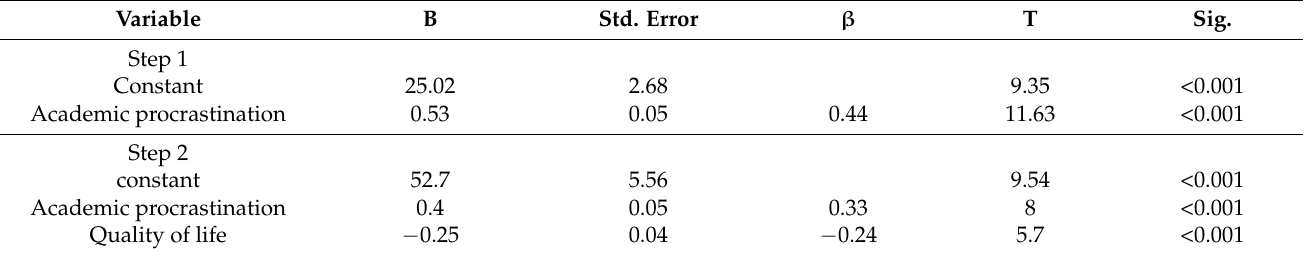
Table 4. Predictive Power of Academic Procrastination and Quality of Life with Addiction to